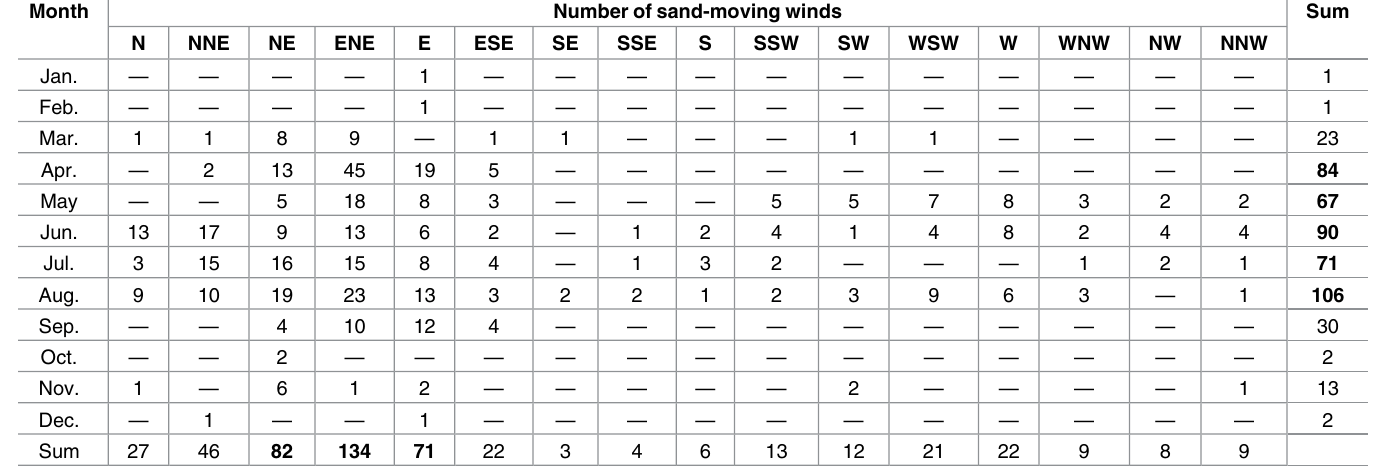
Table 3. Monthly number of sand-moving winds with a speed of (cid:21) 6 m/s (average number for